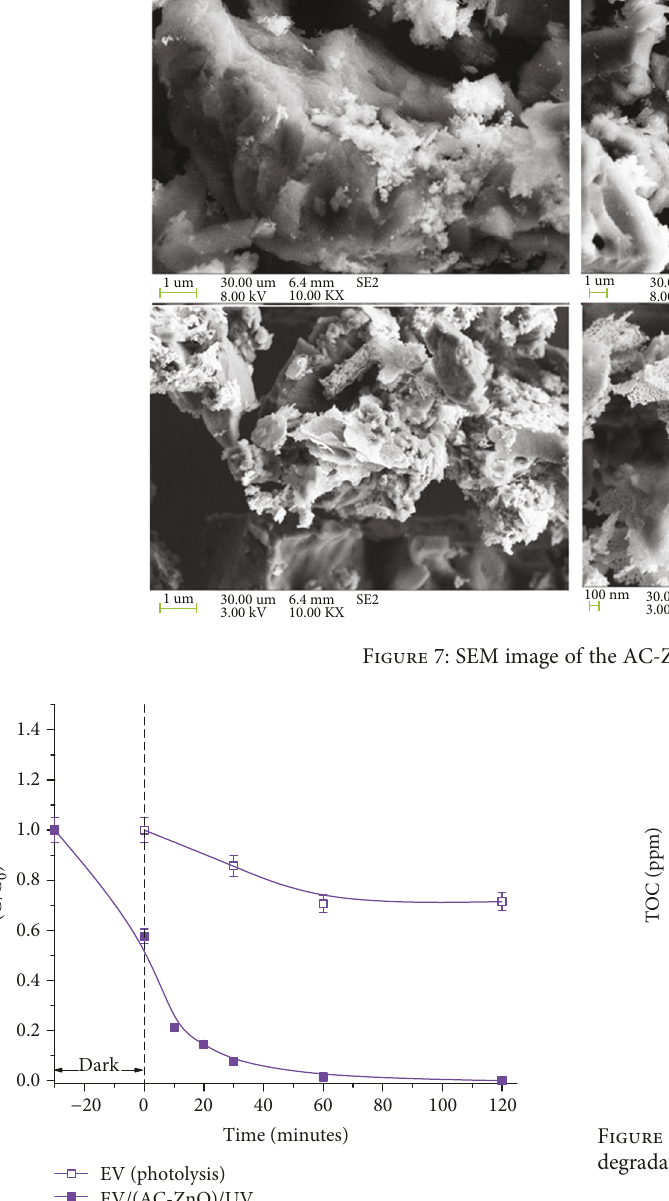
Figure 8: Plot of C / C vs. time for direct photolysis ( □ ) and the 0 degradation of EV ( ■ ) in the presence of AC-ZnO under UV illumination.